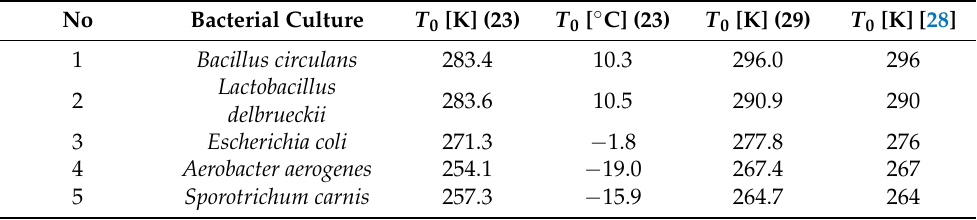
Table 4. Temperatures T 0 for different bacterial cultures corresponding to the plots in Figure 12.